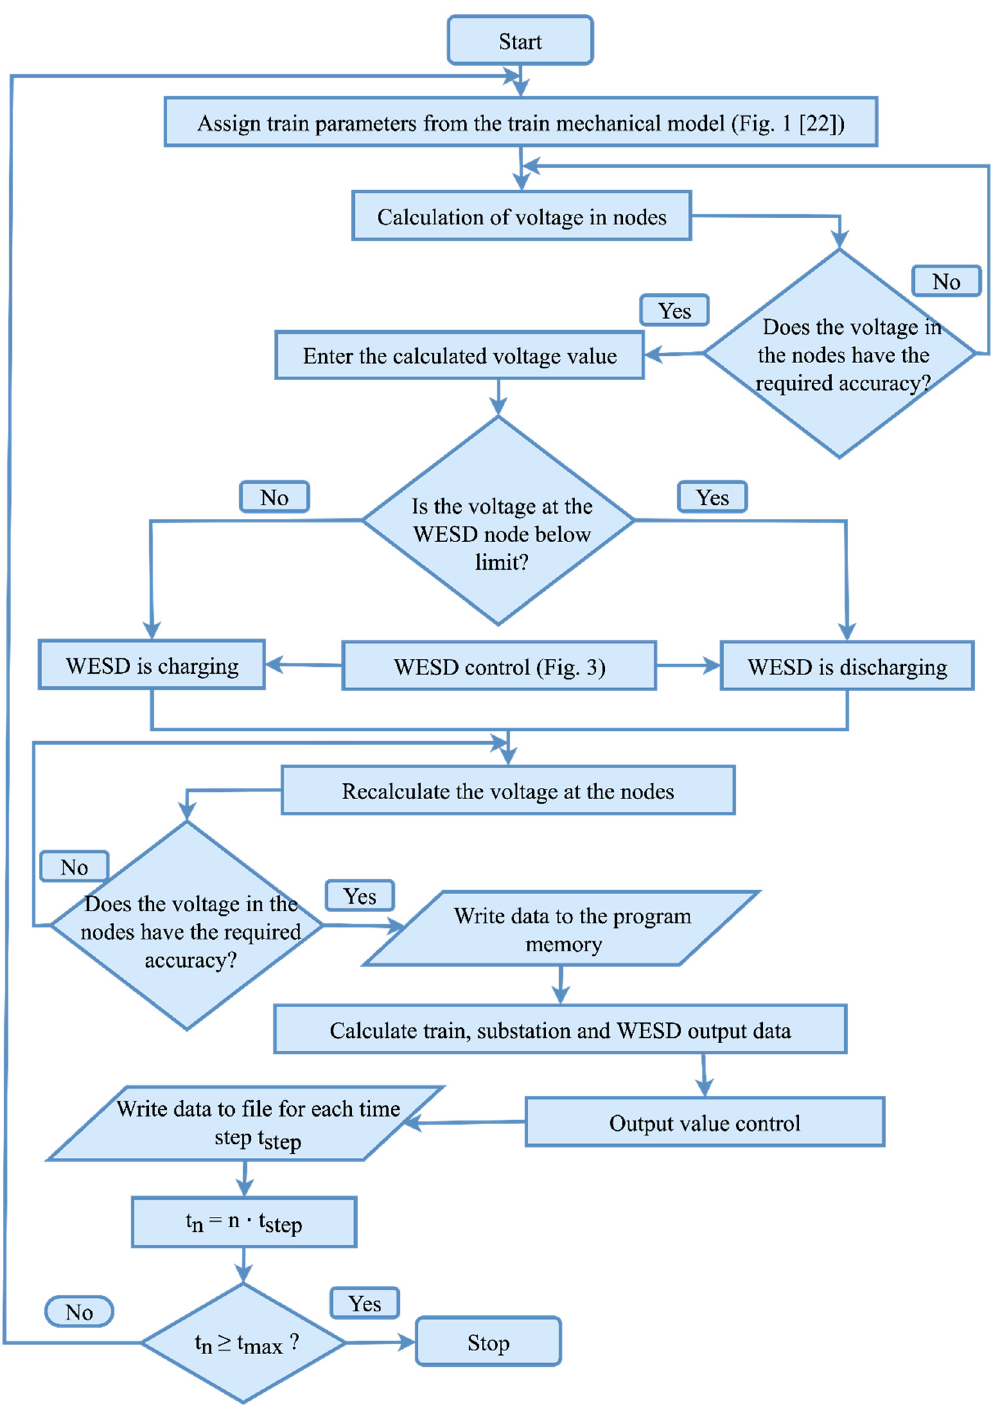
Figure 2. Flowchart of the simulation program for load flow calculations.